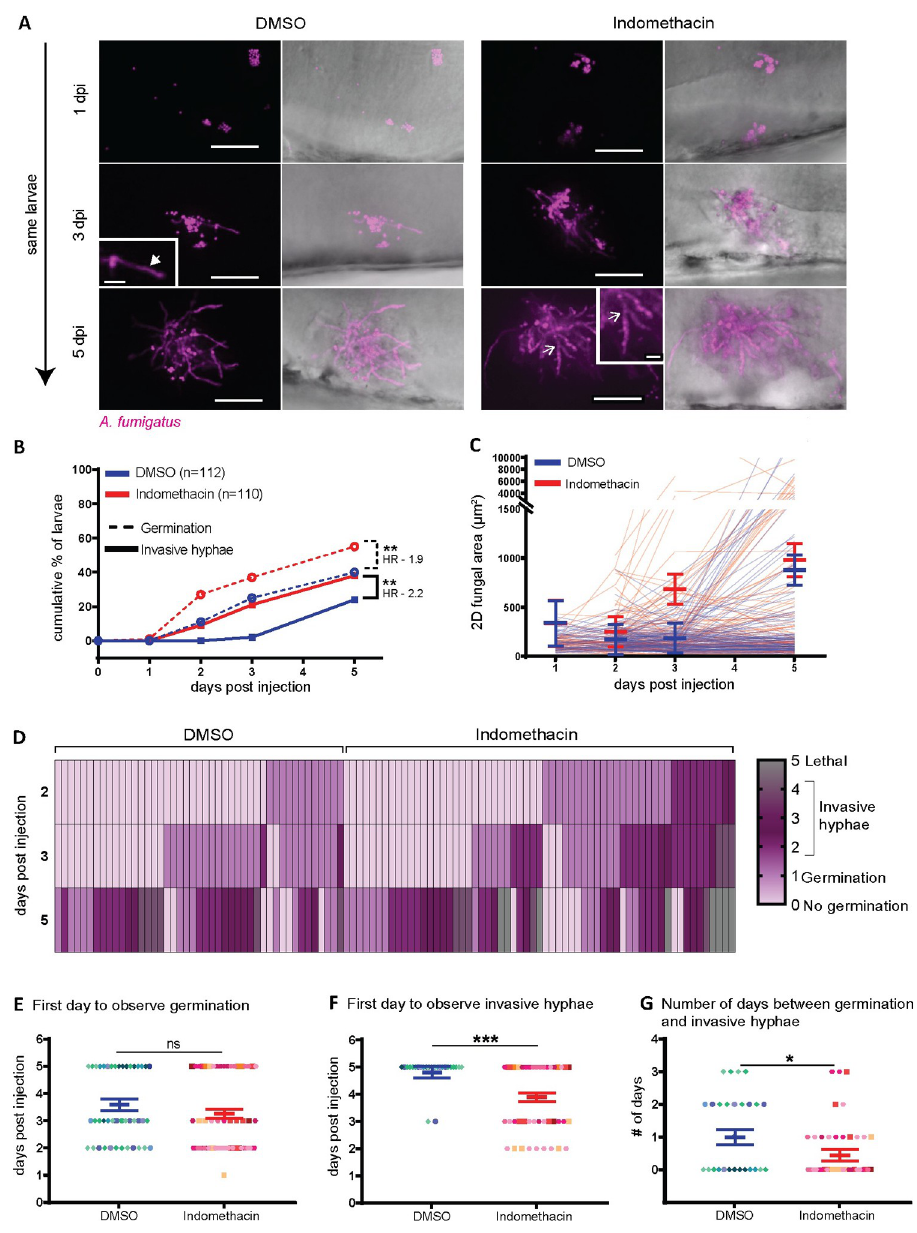
Fig 5. Cyclooxygenase inhibition decreases immune control of fungal germination and invasive hyphal growth. Zebrafish larvae were injected with mCherry-expressing TBK5.1 (Af293) spores at 2 dpf, exposed to 10 μ M indomethacin or DMSO vehicle control and imaged at 1, 2, 3, and 5 dpi. (A) Representative images showing spore germination (inset white arrow) and invasive hyphae (branched hyphae, inset open white arrow). Scale bar = 50 μ m (10 μ m in insets). (B) Cumulative percentage of larvae with germination (dotted line) and invasive hyphae (solid line) through 5 dpi. Cox proportional hazard regression analysis was used to calculate P values and hazard ratios (HR). (C) 2D fungal area was quantified from image z projections. Each line represents an individual larva and bars represent pooled emmeans ± SEM from 8 independent replicates, at least 12 larvae per condition, per replicate. (D) Severity of fungal growth was scored for all larvae and displayed as a heatmap. Representative images for each score can be found in S7 Fig. (E-G) In larvae in which (E) germination (indomethacin n = 61, DMSO n = 45) and (F) invasive hyphae occurred (indomethacin n = 42, DMSO n = 27), the day on which each was first observed is plotted. (G) The number of days between germination and invasive hyphae was also calculated. Bars represent pooled emmeans ± SEM from eight individual replicates, P values calculated by ANOVA. Each data point represents an individual larvae, color- coded by replicate.